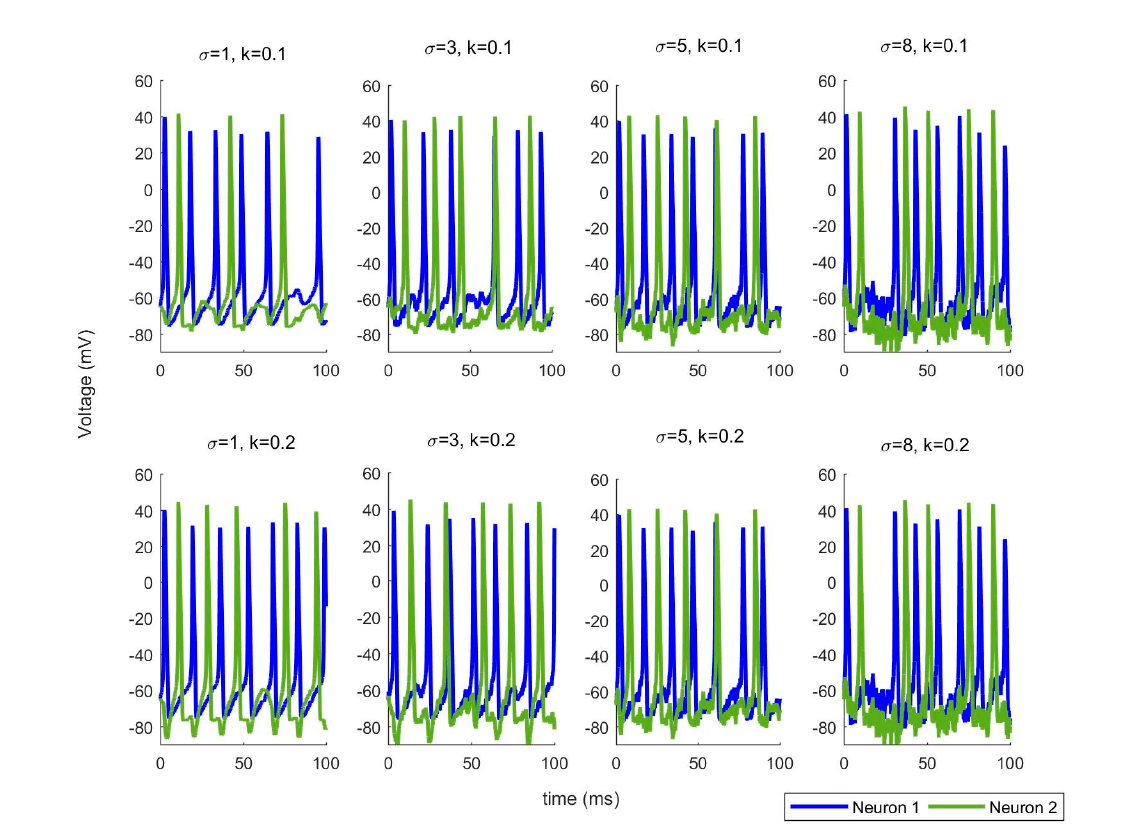
Figure 2. Noise changes the synchronization of the network.